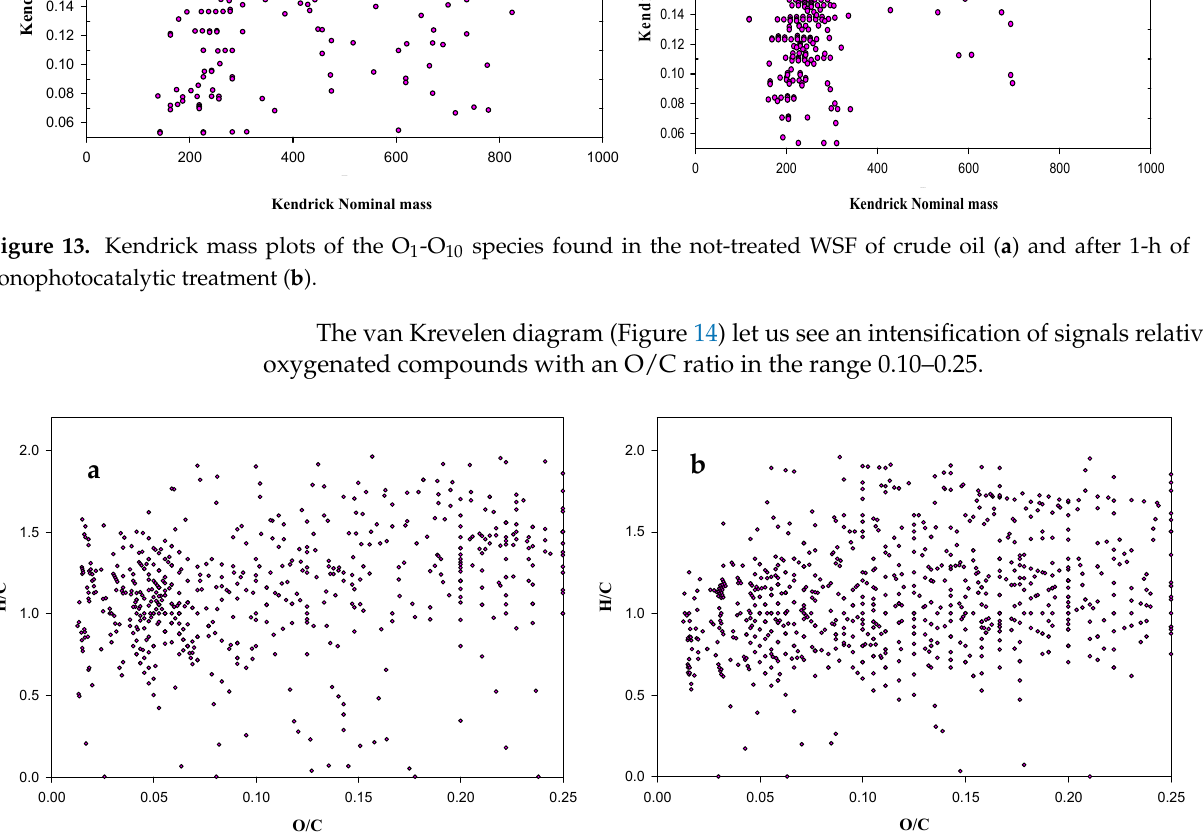
Figure 13. Kendrick mass plots of the O 1 -O 10 species found in the not-treated WSF of crude oil ( a ) and after 1-h of sono- photocatalytic treatment ( b ).